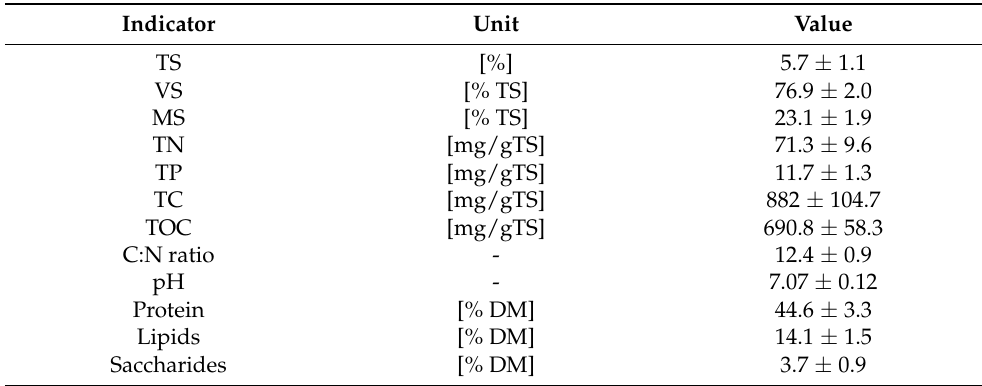
Table 2. Characteristics of anaerobic sludge